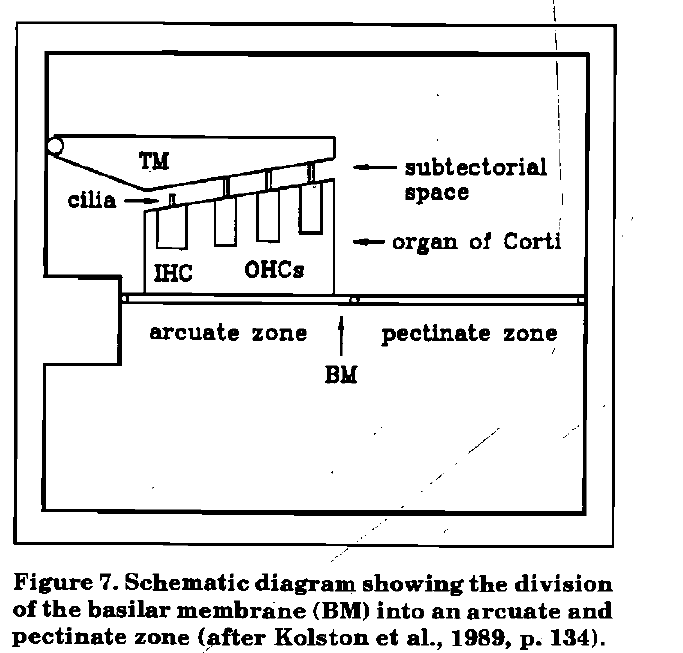
Figure 7. Schematic diagram showing the division of the basilar membrane (BM) into an arcuate and pectinate zone (after Kolston et al., 1989, p.